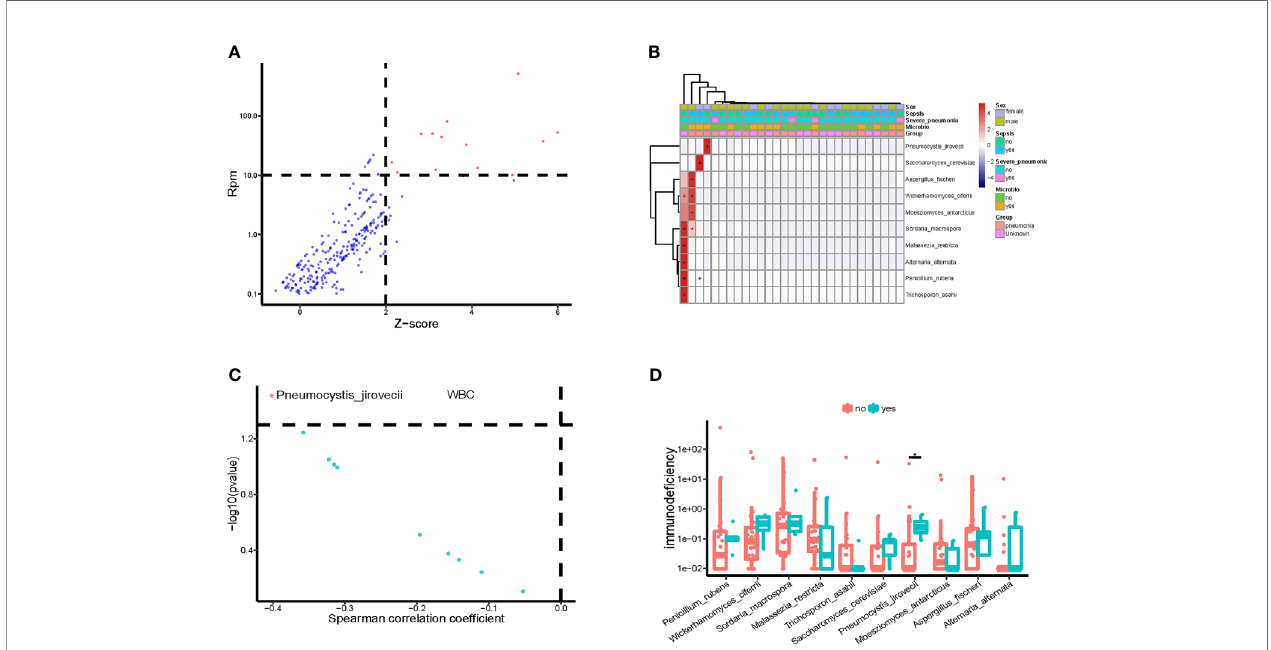
FIGURE 4 | Potential pathogenic fungi in blood of children in PICU. (A) Identi fi ed bloodstream pathogenic fungi. (B) Heatmap of bloodstream pathogenic fungi. (C) Correlation of potential pathogenic fungi and white blood cell count (WBC). (D) Compared with non-immune de fi cient children, the bloodstream abundance of Pneumocystis jirovecii was signi fi cantly higher in children with immunode fi ciency disease, P < 0.05, Wilcoxon rank-sum test. *P <